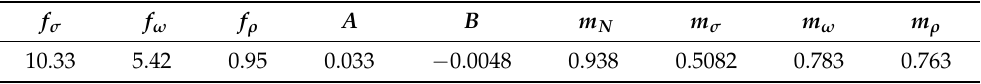
Table 1. Parameters in the relativistic mean-field model with f i = ( g 2 B ≡ b / g 4 σ , and vacuum masses of nucleon and all mesons in GeV unit. f